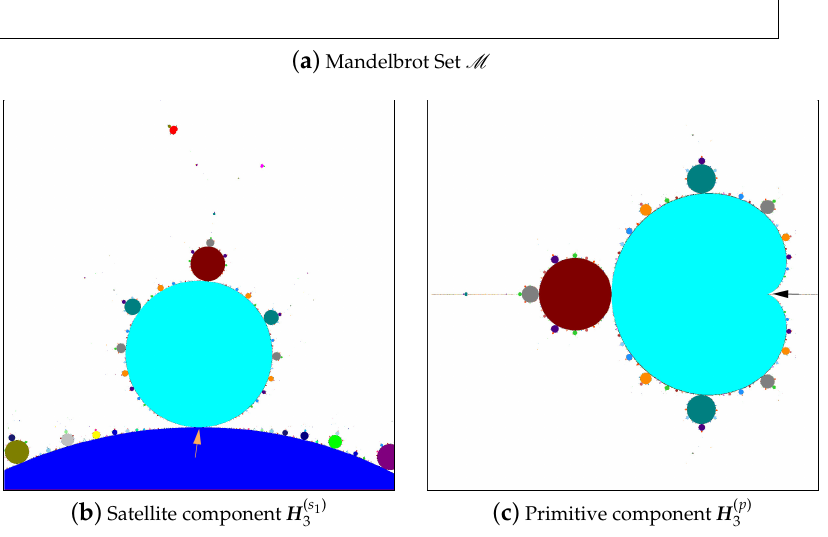
Figure 2. M , period-3 components H ( s )